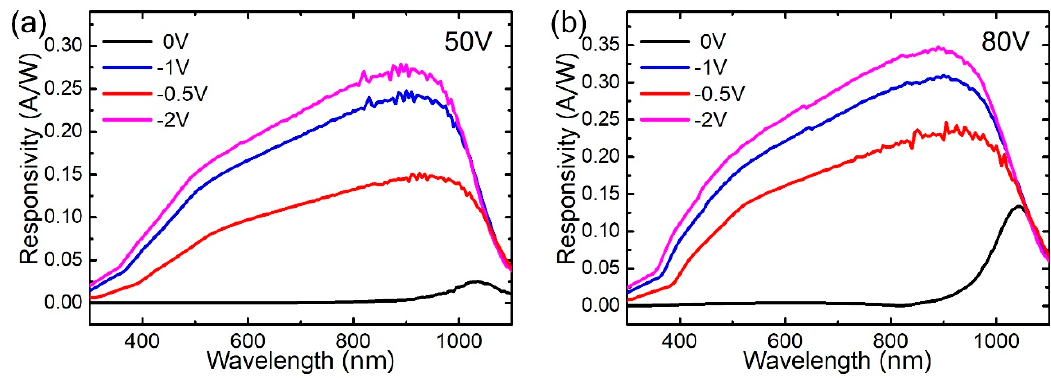
Figure 4. ( a ) The variation of the photocurrent responsivity ( V dep = 50 V) in the wavelength range from 300 to 1100 nm under different bias voltages ( V diode = 0 V, − 0.5 V, − 1 V, − 2 V). ( b ) The variation of the photocurrent responsivity ( V dep = 80 V) in the wavelength range from 300 to 1100 nm under different bias voltages ( V diode = 0 V, − 0.5 V, − 1 V, − 2 V). Applying a reverse bias voltage will cause a blue shift in the response peak.